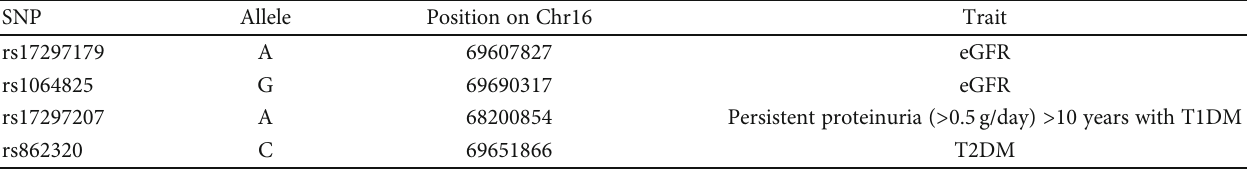
Table 1: Diabetes-associated intronic single-nucleotide polymorphisms in NFAT5 [6 – 10]. SNP